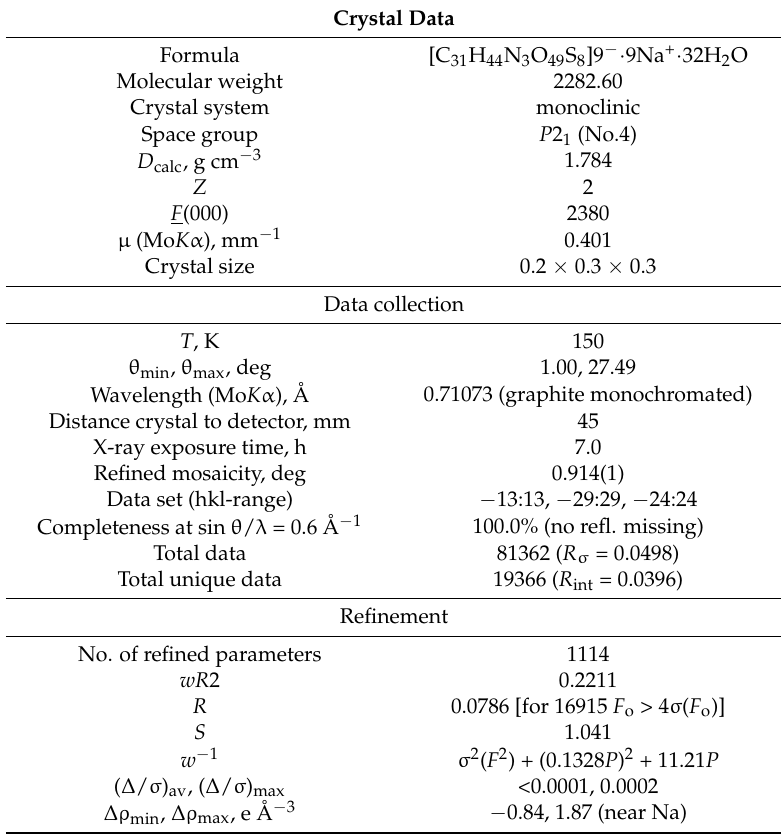
Table 6. Crystallographic data. Unit cell parameters are listed in Table